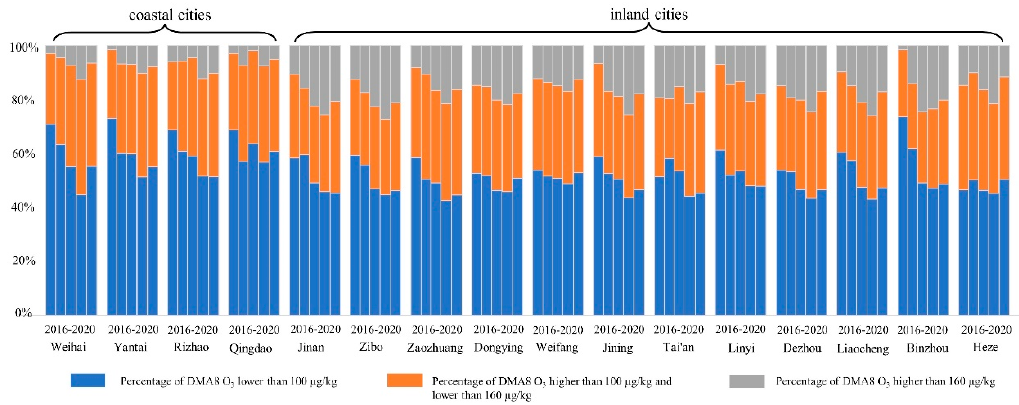
Figure 3. Annual change of O 3 concentration attainment rate from 2016 to 2020.